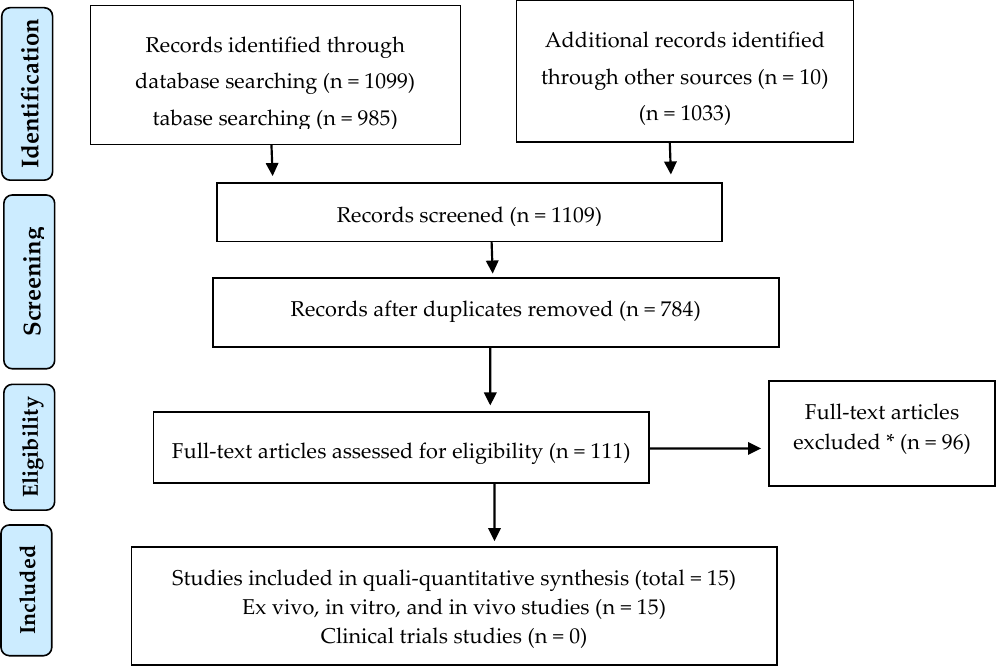
Figure 2. PRISMA (Preferred Reporting Items for Systematic Reviews and Meta-Analyses) flow diagram for studies retrieved through the searching and selection process. * The reasons for the exclusion of articles were the lack of critical information and methodological shortcomings (see Methods section).